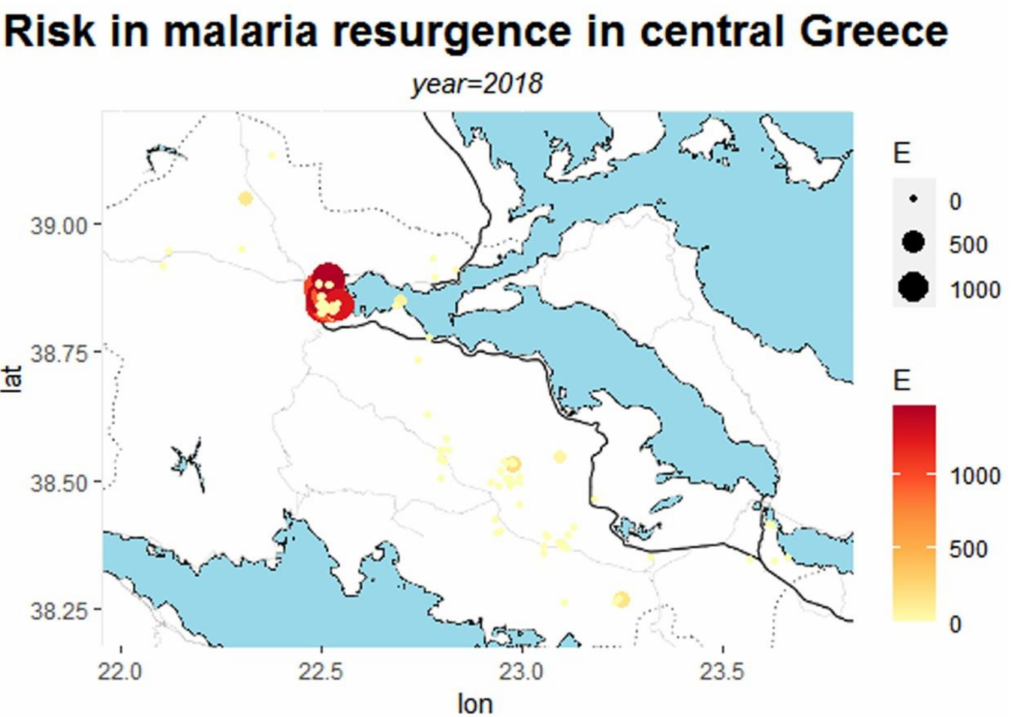
Figure A3. Point estimate map of risk of malaria transmission ( E